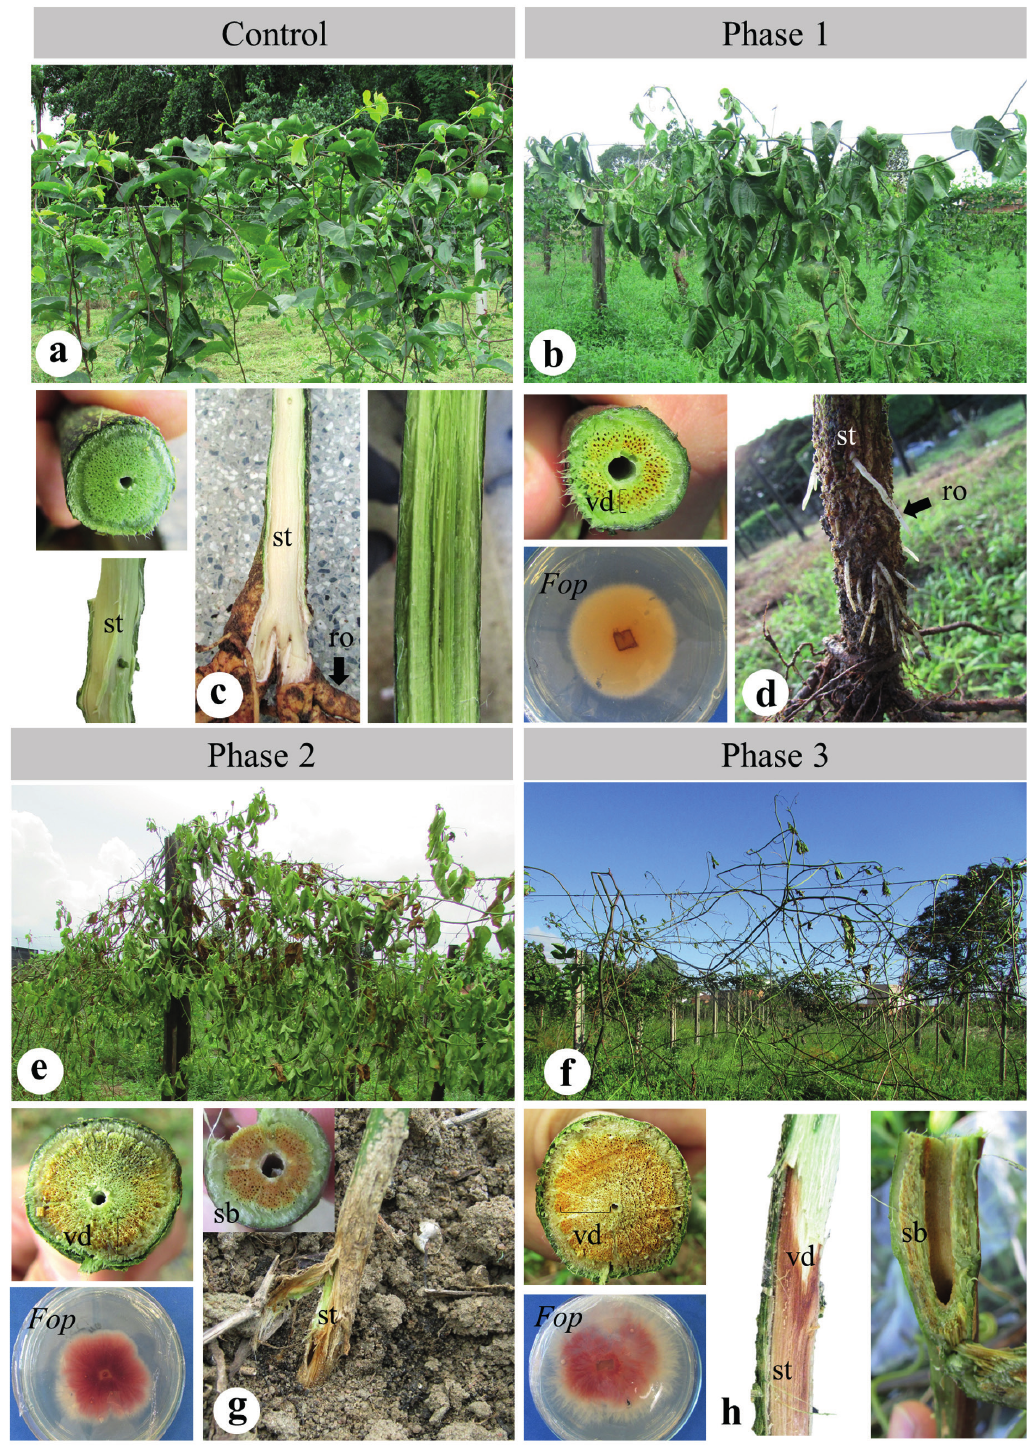
Figure 2 - Morphological aspects of non-grafted plants of yellow passion fruit ( Passiflora edulis Sims.) at different stages of Fusarium wilt. a-c : healthy plant. b-d : first stage of wilt. e- g : second stage of wilt. f-h : third stage of wilt. st: stem, vd: vascular discoloration, sb: secondary branch, ro: root, Fop : Fusarium oxysporum f. sp. passiflorae